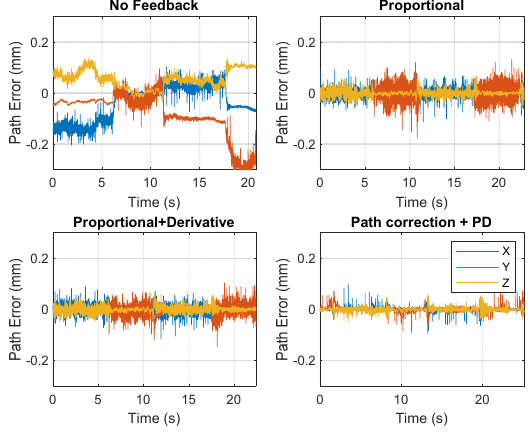
Figure 11. Error vector vs. time for a square trajectory demonstrating the effect of using path correction vs. position correction in jitter noise reduction.